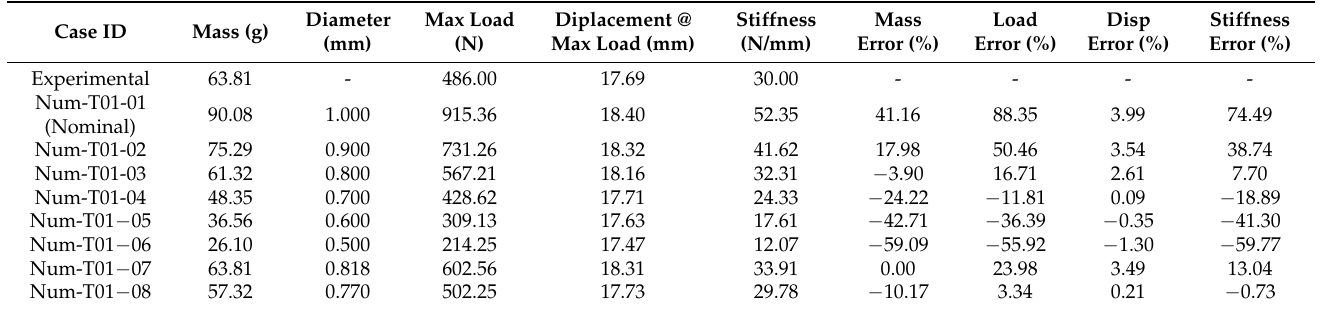
Figure 12. Influence of trusses’ diameters on the structural performance of specimen Type01. Table 4. Sensitivity analysis results -Specimen Type01.